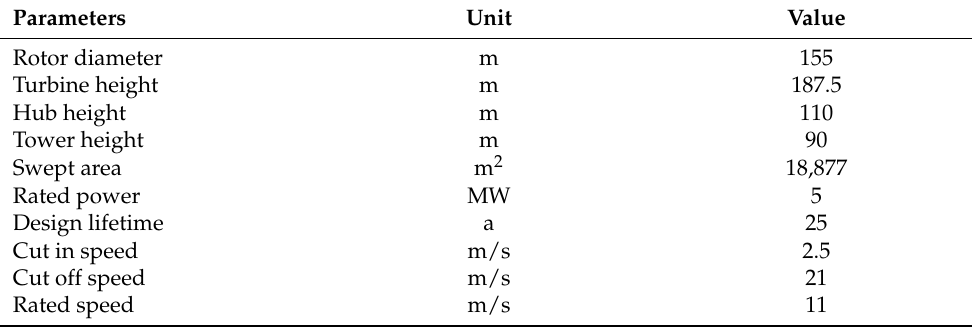
Table 1. Wind turbine